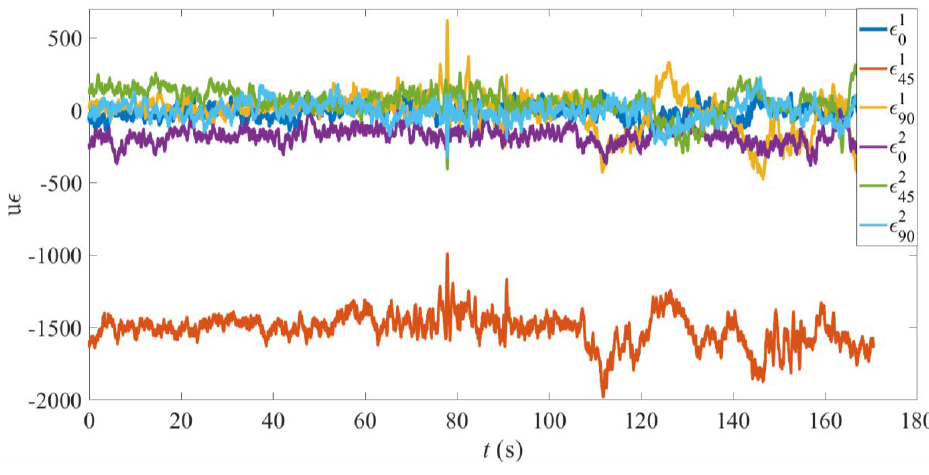
Figure 13. Strain responses on the steering arm.